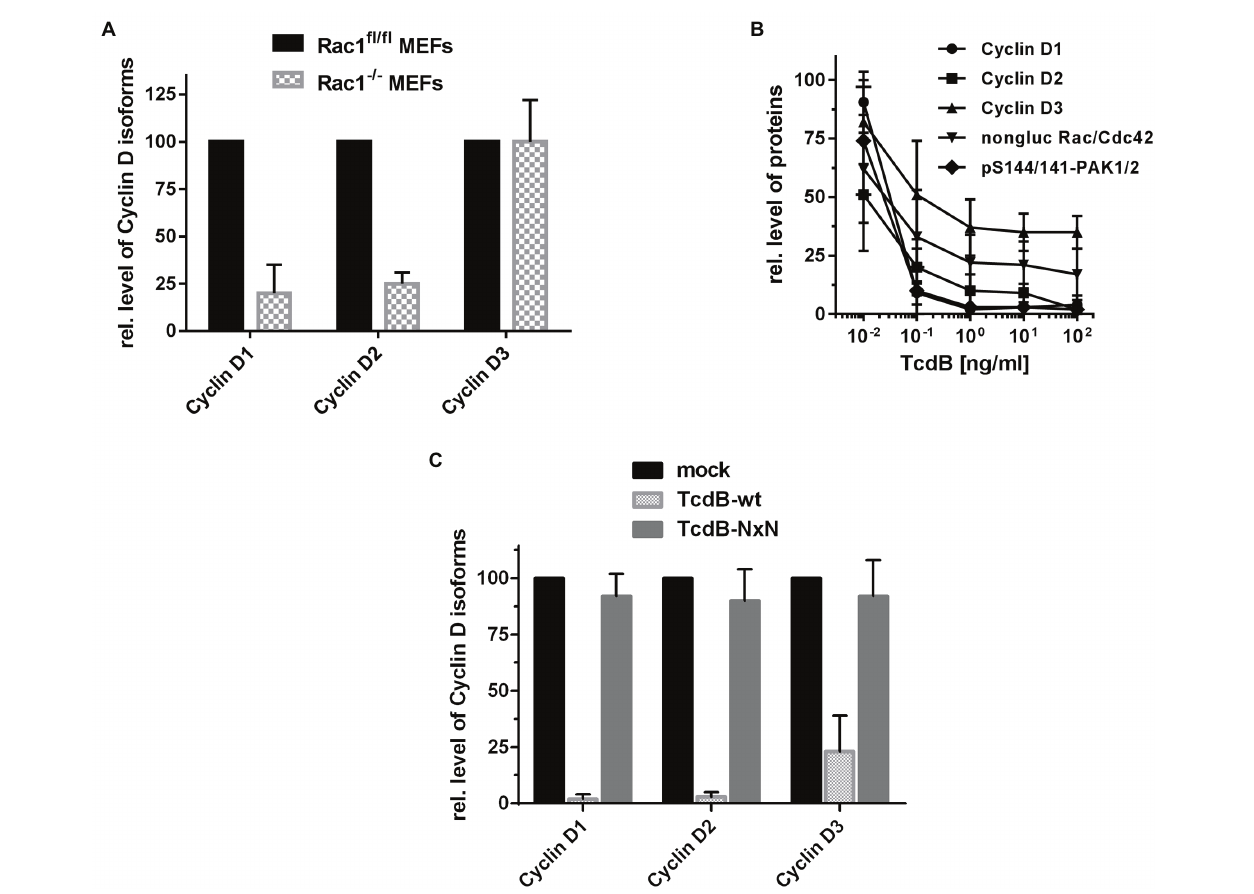
FIGURE 3 | Expression of Cyclin D isoforms upon Rac1 deletion and TcdB treatment. (A) Lysates from proliferating Rac1 fl/fl and Rac1 − / − MEFs were analyzed for the cellular concentrations of the Cyclin D isoforms using Western blot analysis. (B) Proliferating Rac1 fl/fl MEFs were treated with the indicated concentrations of TcdB for 24 h. (C) Proliferating Rac1 fl/fl MEFs were treated with TcdB-wt and TcdB-NxN (1 ng/ml each) or mock for 24 h. The relative cellular concentrations of the indicated proteins were determined using Western blot analysis. Signal intensities obtained from Western blots ( n = 3) were quantified and normalized to the signal of beta-actin. The concentration of the indicated proteins in non-treated cells was set 100. Values are given as mean ± SD of three independent